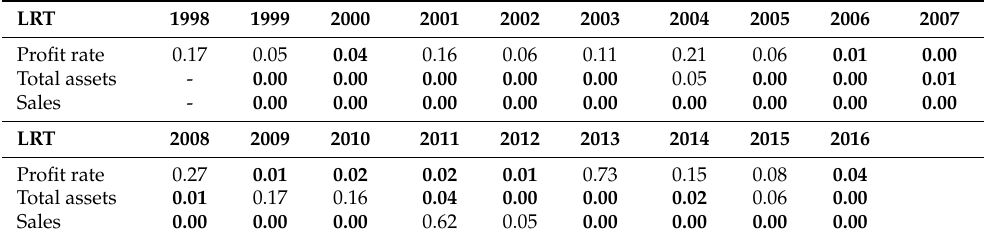
Table A1. P -values of the likelihood ratio test for profit and growth rates of total assets and sales. The null hypothesis is the Laplace distribution, while the alternative hypothesis is the Subbotin distribution. The results refer to the 200 largest long-lived firms according to their sales in 2016. In bold, we underlined P -values below 5%.